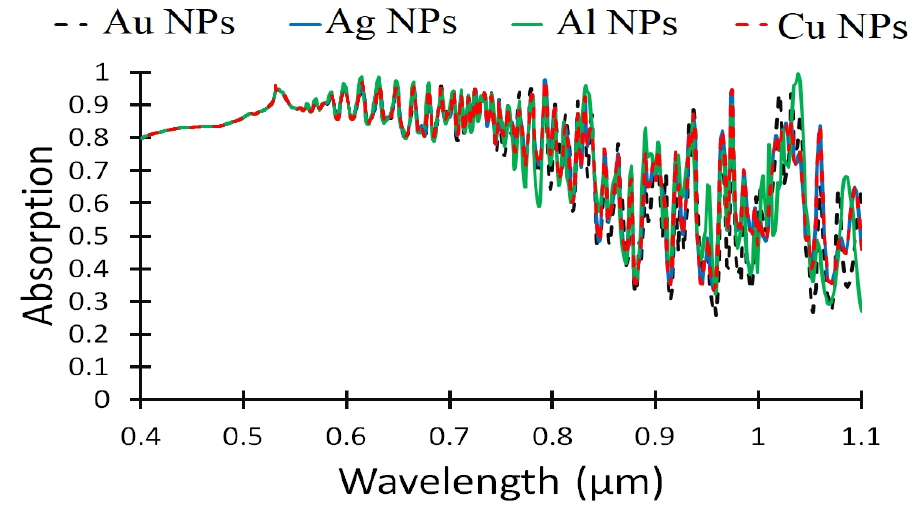
Table 4. Short-circuit current density and overall efficiency for different NP materials. Figure 7. Absorbed energy as a function of wavelength for different NP materials.